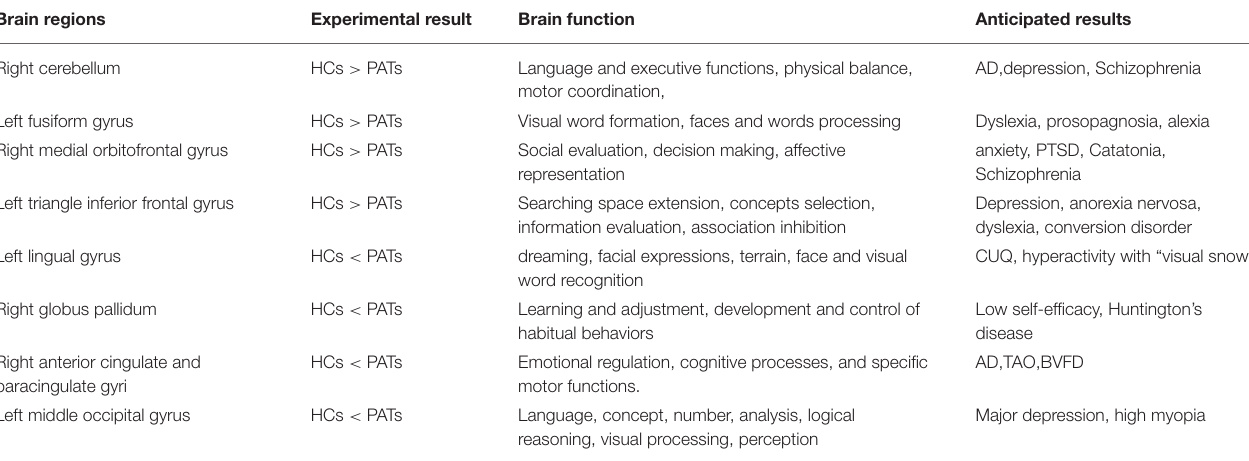
TABLE 4 | Brain regions alternations and its potential